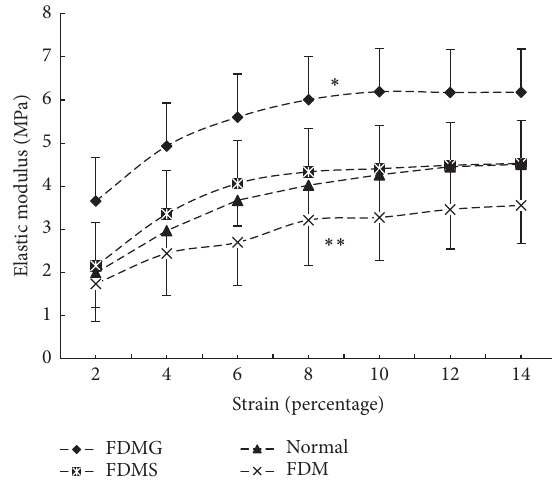
Figure 4: Differences in elastic modulus of the right eyes of all four groups. A single asterisk indicates that the elastic modulus in the FDMG group was significantly higher than in the other groups ( 𝑝 < 0.05 ). A double asterisk indicates that the elastic modulus in the FDM group was lower than in the normal control group; the difference was not significant ( 𝑝 > 0.05